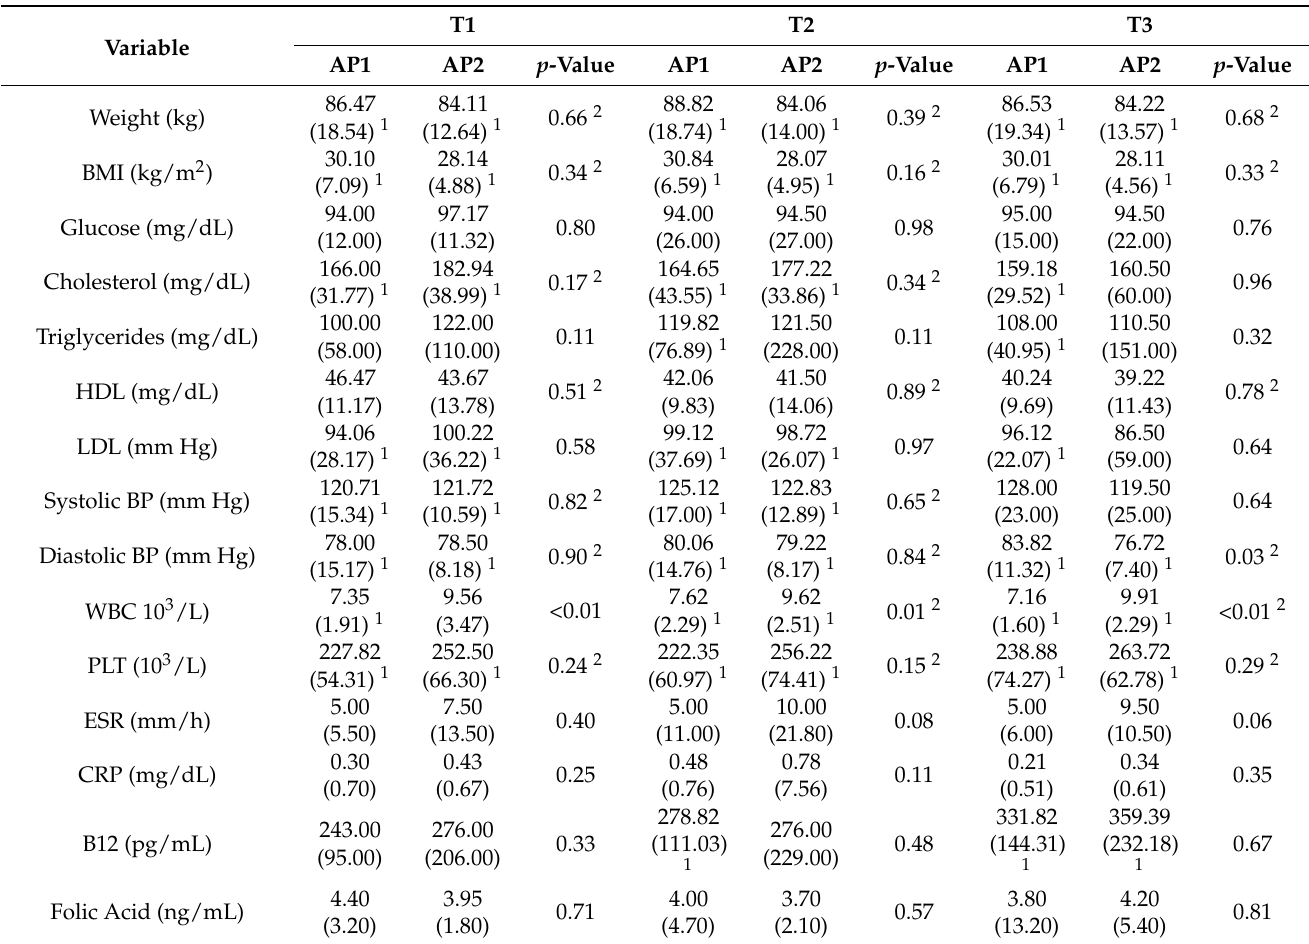
Table 3. Differences between subgroups of forensic psychiatric patients receiving antipsychotic medication AP1 and AP2 at the three yearly time points (T1: 2018, T2: 2019, T3: